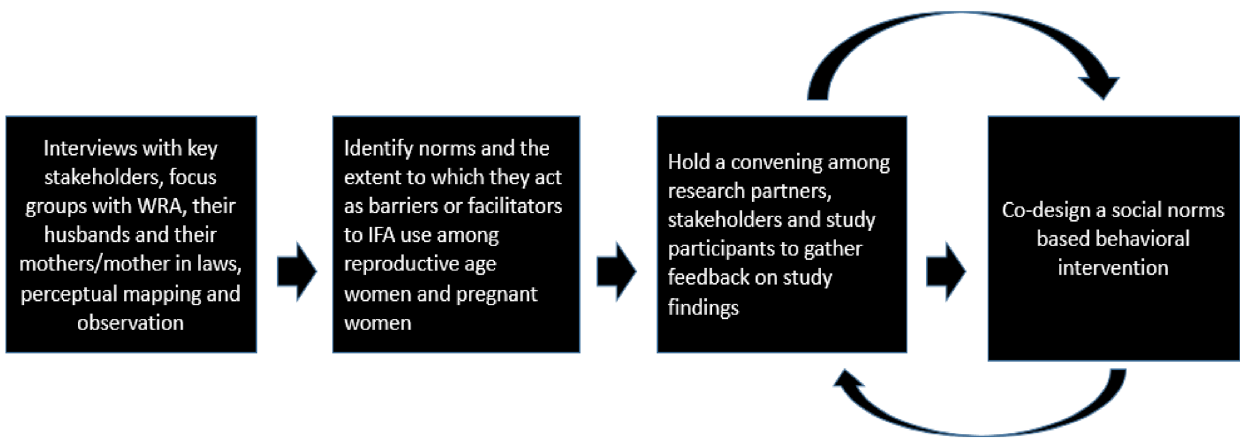
Figure 1. Formative Research